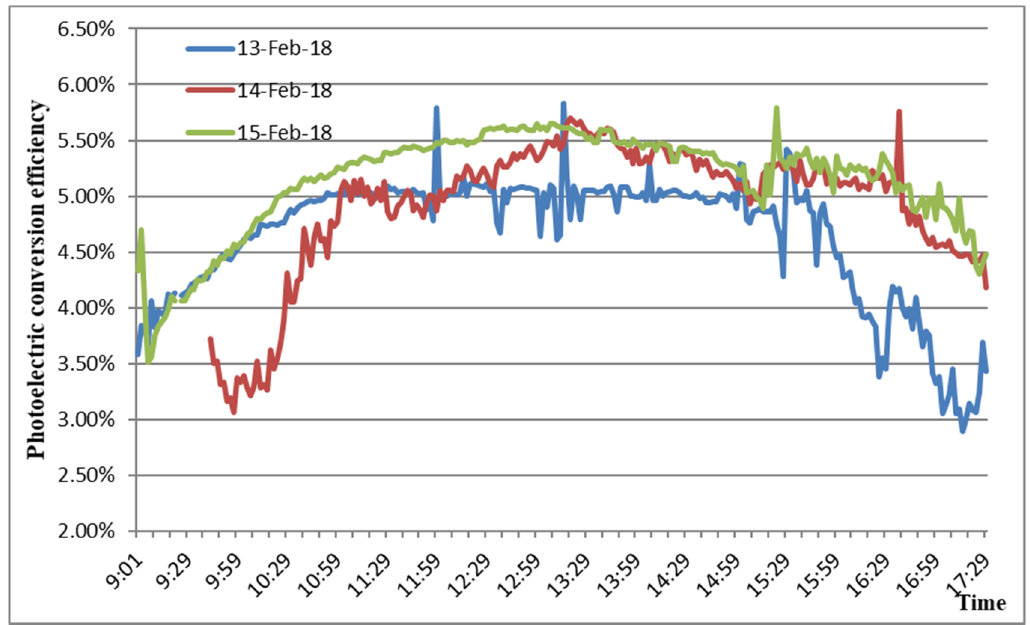
Figure 8. Photoelectric conversion efficiency.